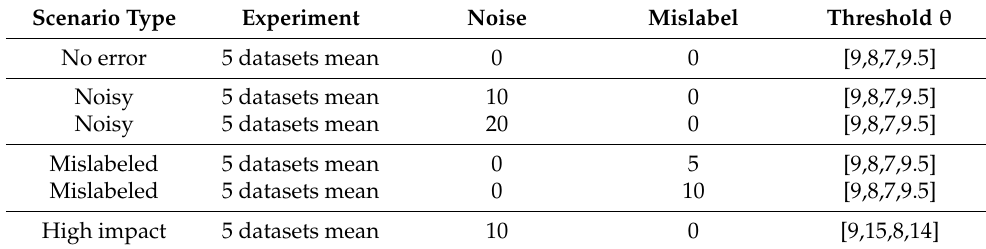
Table 2. Scenarios, noise and mislabeling levels and threshold limits for simulated datasets. Scenario